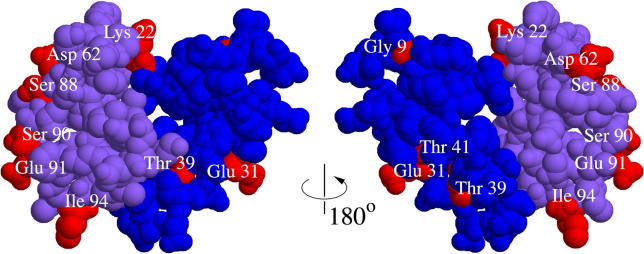
Positively Selected Sites on MSMB are Spread across the Protein Surface.According to sites models of codon evolution, 42% of MSMB residues experienced adaptive pressure to alter their amino acids. Those predicted with high support are shown in red on this threaded structural model of human MSMB. Blue and purple residues demarcate two structural domains of the protein [62]. The amino acid sites show no clustering and are almost significantly dispersed throughout the protein (p = 0.066). This pattern is quite different from that shown by KLK2 (Figure 3). Although MSMB is one of the most abundant human seminal proteins, its function remains unknown.